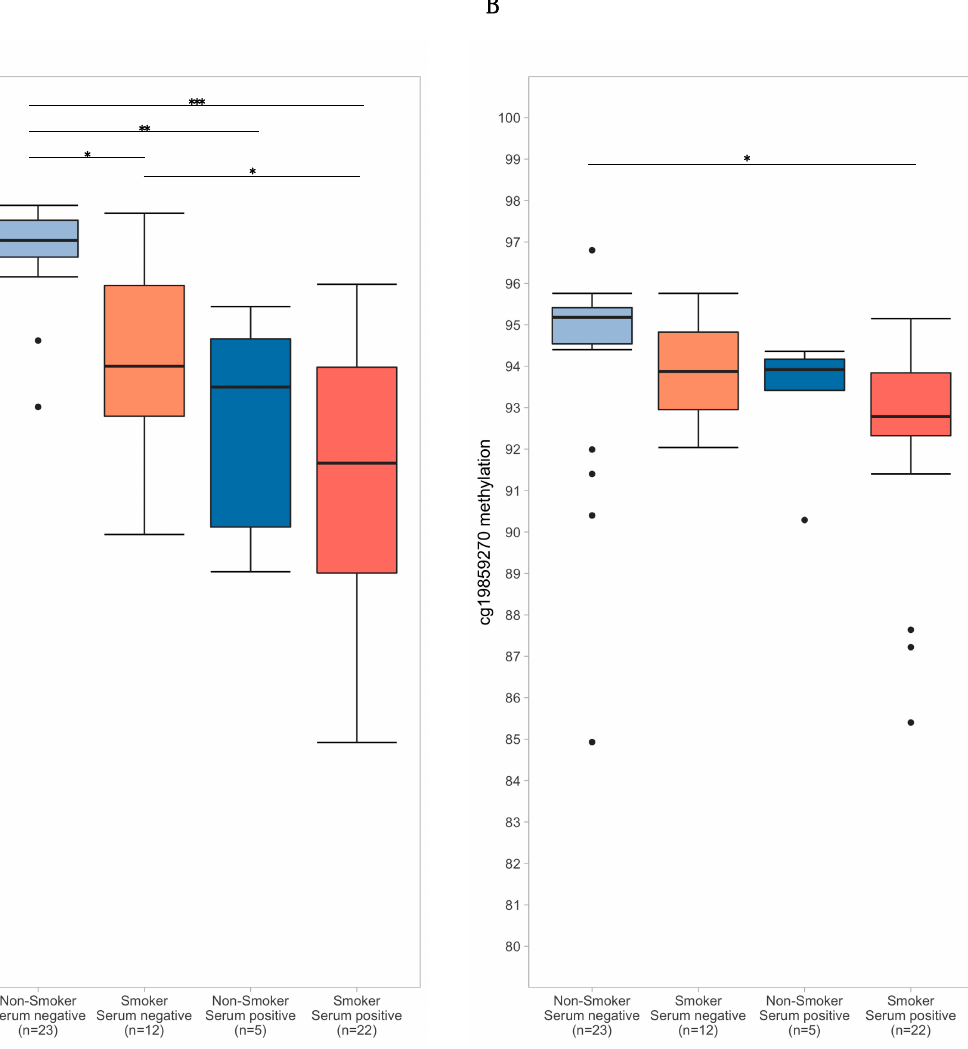
Figure 2. Boxplots of cg05575921 ( A ) and cg19859270 ( B ) methylation stratified by self-reported smoking status (tobacco and / or cannabis) and serum positivity (cotinine > 1 ng / mL and / or tetrahydrocannabinol (THC) > 0.5 ng / mL). Significance codes: * p ≤ 0.05; ** p ≤ 0.01; *** p ≤ 0.001 (Tukey’s Honest Significant Difference).